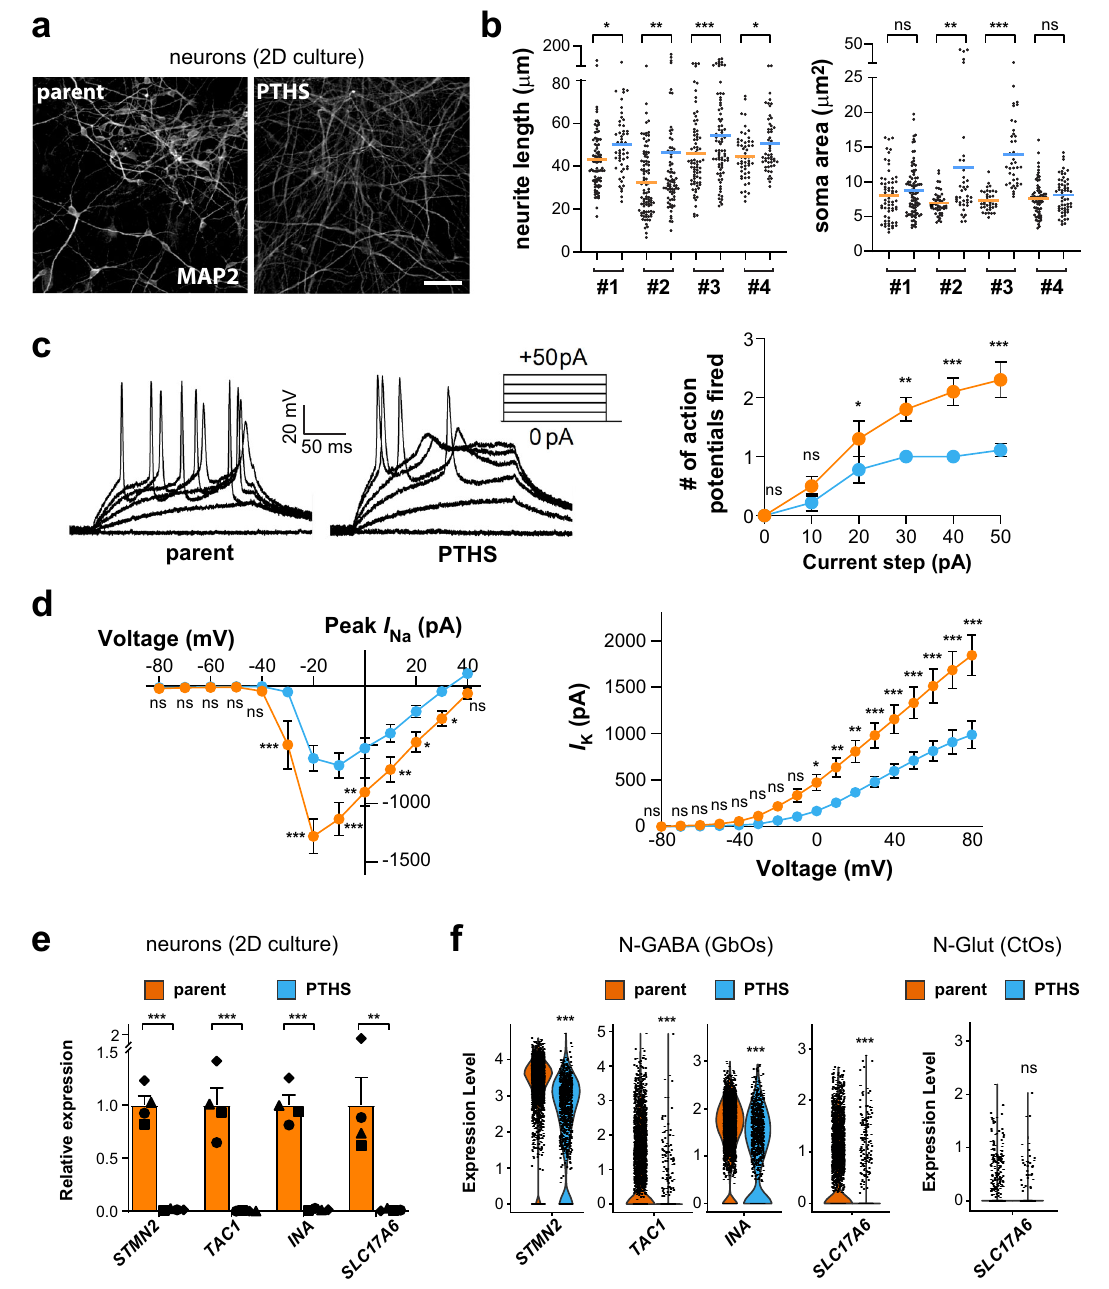
Fig. 4 PTHS neurons exhibit abnormal electrophysiological properties and gene-expression program. a Neurons in 2D culture (3 months in neuronal medium) after MAP2 immunostaining (white). b Neurite length and soma area quanti fi cation in parent and PTHS neurons in 2D culture. N = 4 patients and respective controls (#1 to #4 pairs indicated below the graphs); 37-94 neurons per group (dots). Means are indicated by the colored lines. c Patch-clamp electrophysiological interrogation of parent and PTHS neurons, showing reduction in spike rate in PTHS neurons after 3 months in neuronal medium (right). Representative traces are shown on the left. N = 10 (parent) or 9 (PTHS) neurons from pair #4. d Sodium (left) and potassium (right) currents in parent (orange) and PTHS (blue) neurons. N = 10 (parent) or 9 (PTHS) neurons. e Relative expression (RT-qPCR) of selected neuronal genes in neurons in 2D culture (2 months in neuronal medium). N = 4 subjects per group (symbols). These genes were selected among the most differentially expressed in N-Glut and N-GABA neurons between parent and PTHS organoids (see Supplementary Data 3 for list of DE genes). f Left: Expression of the same genes shown in ( e ) in neurons of GbOs, at 8 weeks in vitro. N = 2661 (parent) and 988 (PTHS) cells. Right: For comparison with GbOs, the expression of SLC17A6 (vGLUT2) in CtO neurons is also shown. N = 1401 (parent) and 380 (PTHS). Cells are from pair #4. Symbols in bar graphs indicate parent-patient identities: diamonds, pair #1; squares, pair #2; triangles, pair #3; circles, pair #4. Colors in the fi gure represent parent (orange) or PTHS (blue) groups. Bar graphs represent mean + SEM. n.s., not statistically signi fi cantly different, * p < 0.05, ** p < 0.01, *** p < 0.001; one-way ANOVA with Geisser-Greenhouse correction for repeated measures followed by LSD post-hoc test ( b ), one-way ANOVA followed by HSD post-hoc test ( c and d ), two-sample Welch ’ s t test ( e ), or Kruskal – Wallis H test ( f ). Scale bar is 100 μ m. See Supplementary Data 1 for sample and effect sizes and exact p